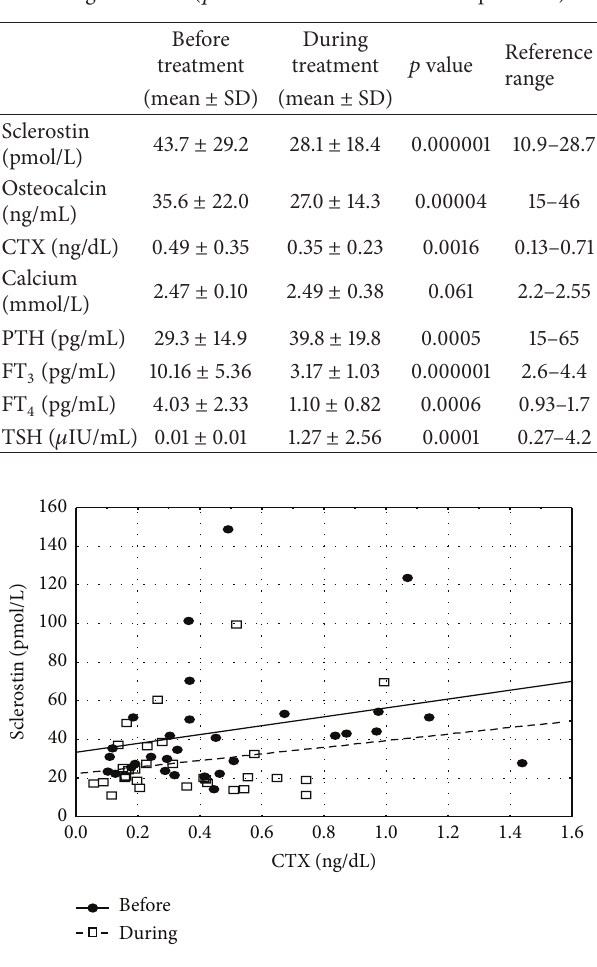
Figure 1: Scatterplot for sclerostin and CTX (before hyperthy- roidism treatment 𝑟 𝑠 = 0.41 , 𝑝 < 0.05 ).